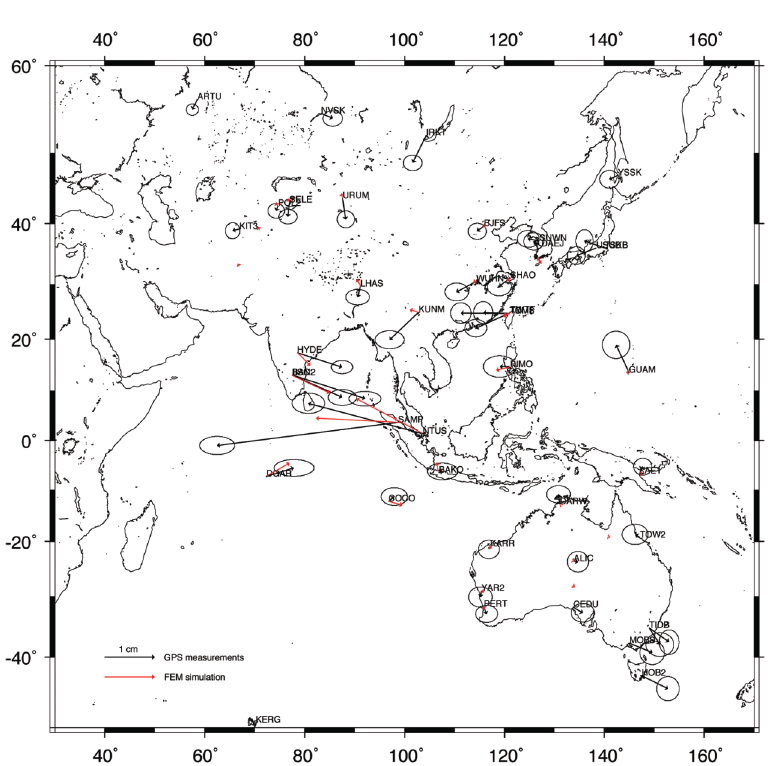
Fig. 25. Comparison between horizontal displacements resulting from the FEM simulation and the GPS meas- urements recorded from permanent stations (here plotted with error ellipses matching 60%